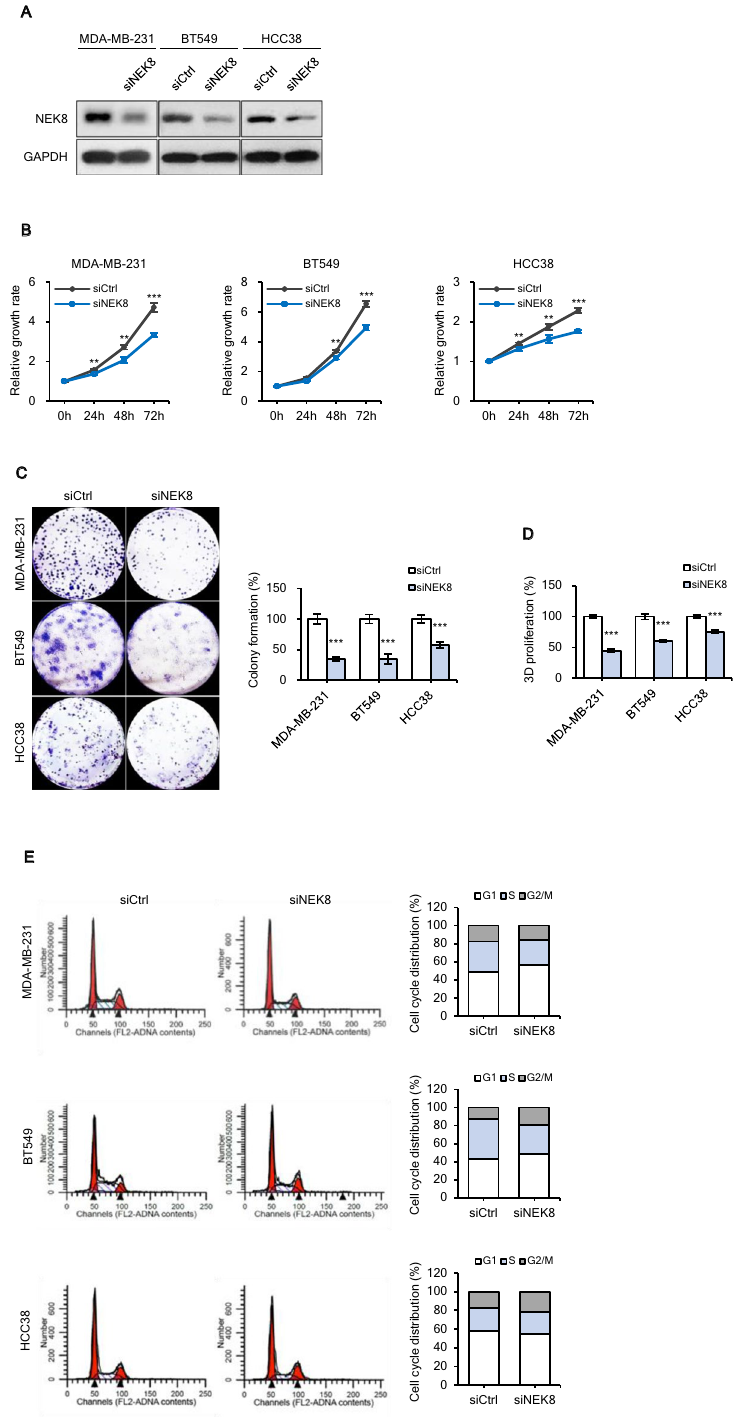
Figure 2. Knockdown of never in mitosis gene A-related kinase-8 (NEK8) attenuates proliferation and induces cell cycle arrest in breast cancer cells. MDA-MB-231, BT549, and HCC38 cells were transfected with control (siCtrl) or NEK8-silencing (siNEK8) small interfering RNA. ( A ) On day 3 after transfection, western blotting was used to confirm the knockdown of NEK8 in the siNEK8 group compared with that in the siCtrl group. ( B ) NEK8 knockdown inhibited the proliferation of breast cancer cells after 24, 48, and 72 h. The graph is representative of at least three independent experiments (n ≥ 3), where each experiment was performed in triplicate. Error bars, standard deviation (SD); *** P < 0.001, ** P < 0.01, * P < 0.05. ( C ) NEK8 knockdown decreased colony formation. Representative images at least three independent experiments that showed similar results of colony growth (n ≥ 3). ( D ) In the 3D Matrigel matrix, cells with NEK8 knockdown showed reduced proliferation after 5 days. Error bars, SD; *** P < 0.001, ** P < 0.01, * P < 0.05. ( E ) Distribution of cell cycle phases measured using flow cytometry. ( F ) Expression of cell cycle-related genes was confirmed using western blotting 72 h after NEK8 knockdown. GAPDH was used as a loading control. The figure is representative of at least three independent experiments that showed similar results (n ≥ 3). The blots were cut prior to incubation with